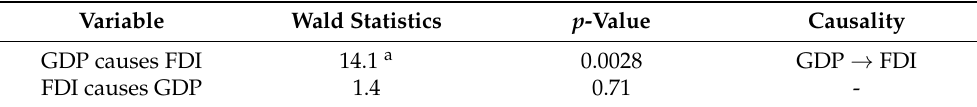
Table 6. Wald test results.